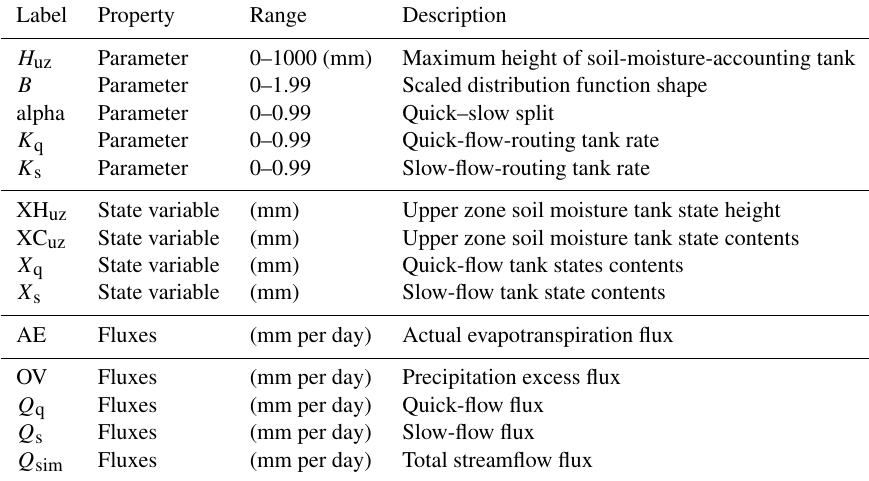
Table A2. Definitions of parameters, state variables, and fluxes used in the HYMOD (Wagener et al.,